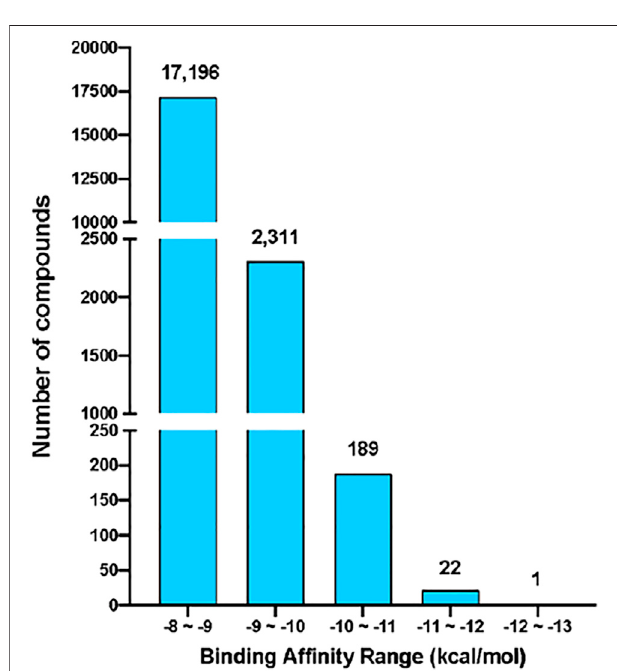
FIGURE 2 | The binding energy distribution of receptor-rigid virtual screening results. Compounds with binding energy below − 8 kcal/mol were categorizedinto fi vegroupsbasedontheirbindingenergyvalues.Thenumber of compounds in each group is shown on the top of the group bar.